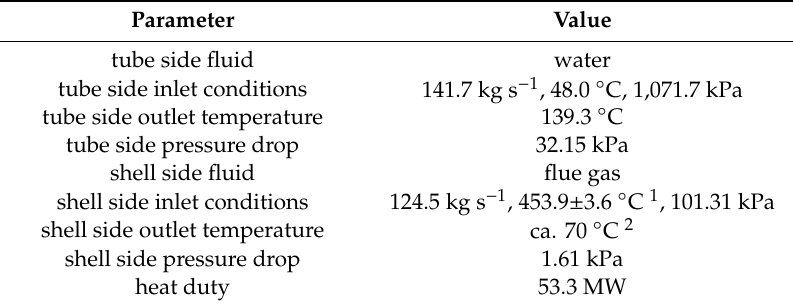
Table 3. Data provided by the operator of the heat recovery hot water